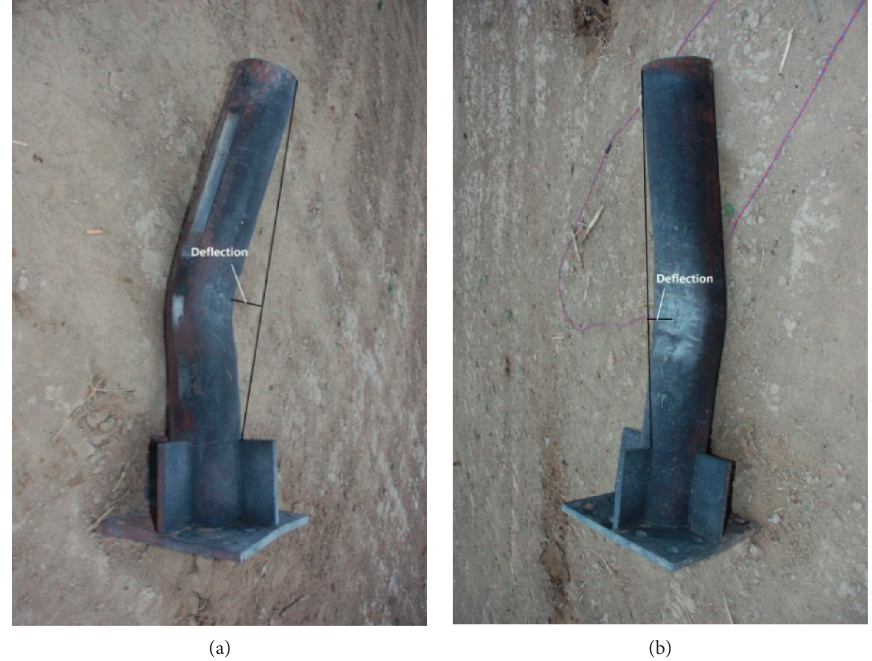
Figure 7: Macroscopic deformation of two CFST columns. (a) CFDST section. (b)